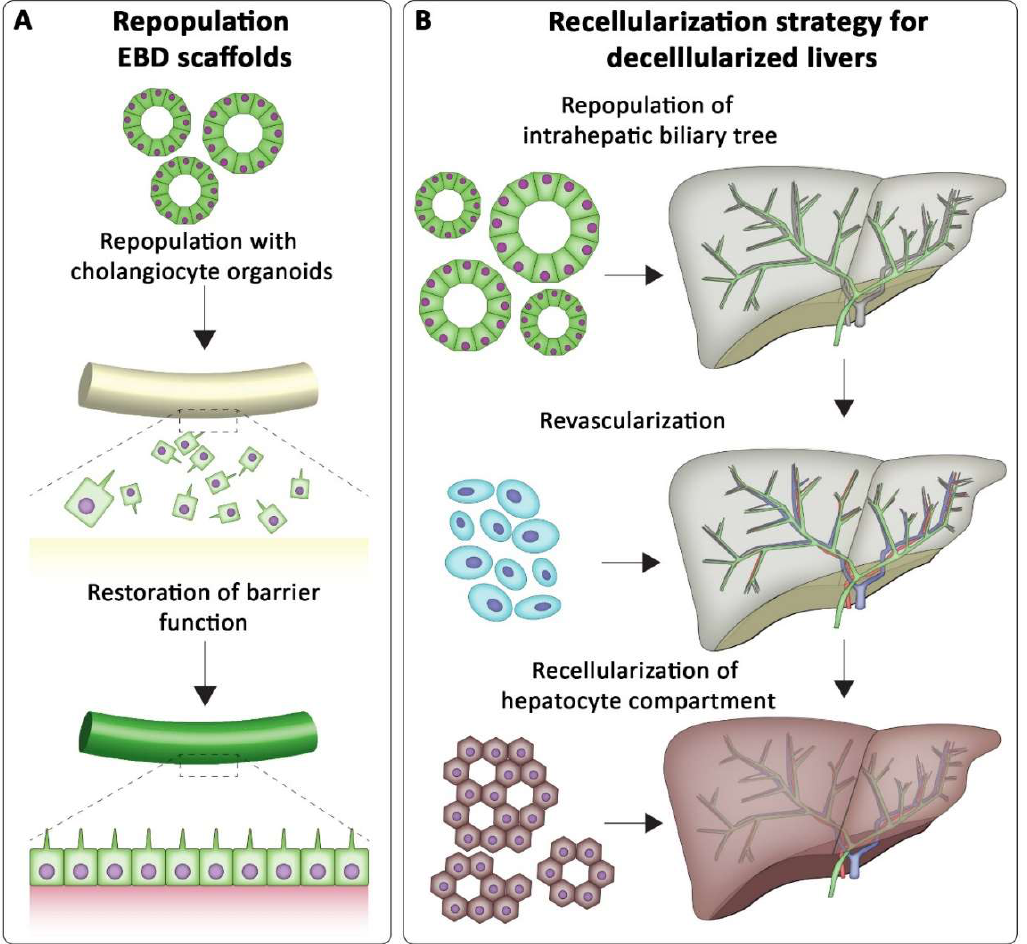
Figure 4. Potential future tissue engineering applications of human cholangiocyte organoids. ( A ) Cholangiocyte organoids can also be used to repopulate extrahepatic bile duct (EBD) scaffolds for